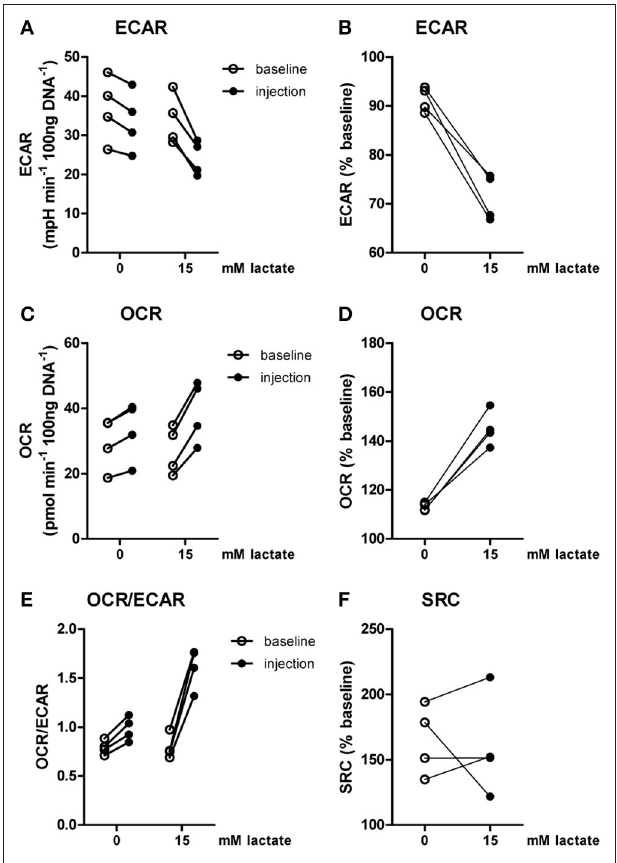
FIGURE 4 | Lactate acutely shifts metabolism of inflammatory human monocytes to oxidative phosphorylation. CD14 + monocytes were stimulated with LPS for 4h before metabolism was assessed. (A–D) Change of ECAR (A,B) and OCR (C,D) in human CD14 + monocytes stimulated for 4h with LPS before exposure to lactate, presented as raw data or % baseline (before lactate injection). (E) OCR/ECAR after lactate injection. (F) Spare respiratory capacity (SRC) after lactate injection. Each dot represents one healthy individual. n = 4, Wilcoxon signed rank test.